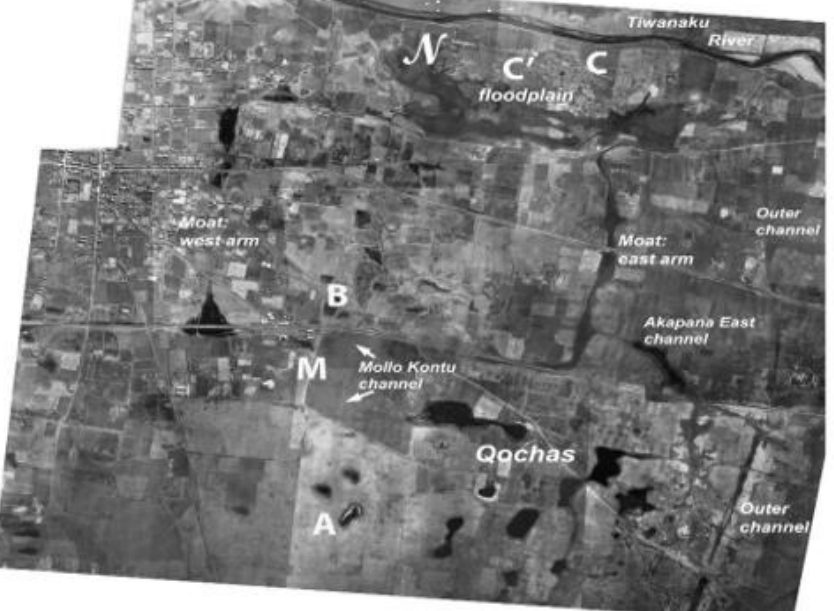
Figure 45. The recently discovered Mollo Contu canal . Figures originally derived from 1940s aerial photos from Alan Sawyer at Tiwanaku and later annotated 2010 by John Janusek.